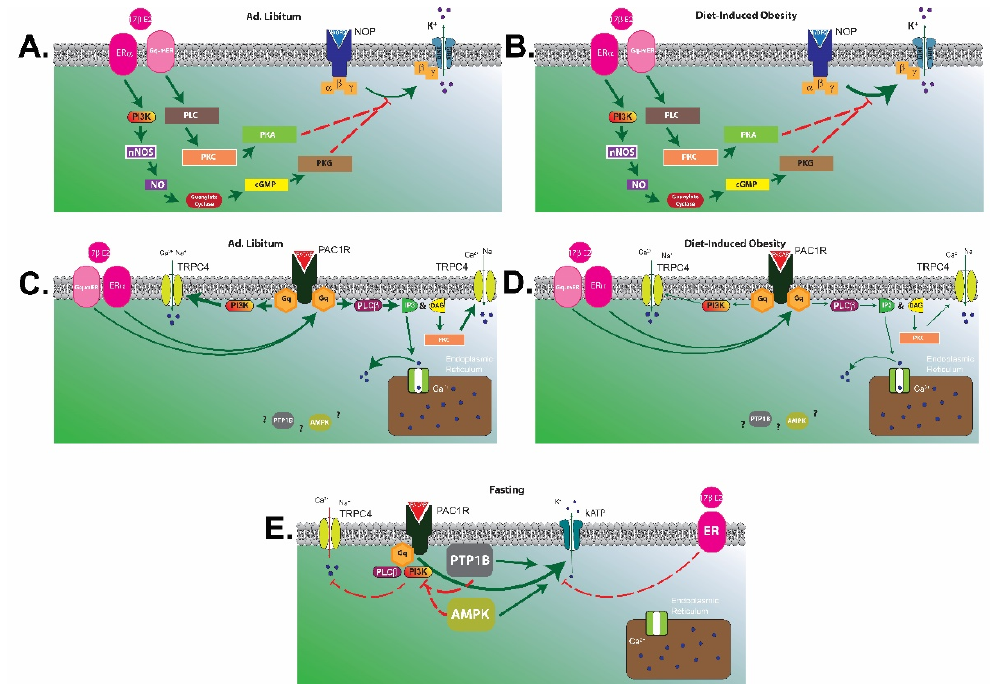
Figure 10. Schematic diagrams illustrating how PAC1 and NOP receptor signaling in POMC neurons is altered under various energy balance states. ( A ), In POMC neurons from ad libitum-fed animals, N/OFQ activates the NOP receptor that initiates G i/o -mediated signaling and subsequent activation of GIRK channels through positive allosteric modification by the βγ complex. This in turn promotes K + efflux and inhibition of POMC neurons, effects which are dampened by E 2 acting through ER α and G q -mER to stimulate PI3K and nNOS as well as PLC, PKC and PKA signaling pathways, respectively. ( B ), In POMC neurons from obese animals, NOP receptor/effector coupling is enhanced; leading to a greater inhibitory effect of N/OFQ on POMC neurons. This N/OFQ-induced inhibition of POMC neurons is once again abrogated by E 2 in POMC neurons from obese females. ( C ), Under ad libitum conditions, PACAP activates its cognate PAC1 receptor to elicit G q -mediated signaling; working through PI3K as well as PLC, IP3, DAG and PKC to promote Ca 2+ mobilization from intracellular stores and the coupling of PAC1 receptors to TRCP5 channels. This leads to cation flux through the channel pore that depolarizes and thereby excites POMC neurons. In females, E 2 can act via ER α and Gq-mER to potentiate PAC1 receptor/TRPC5 channel coupling and PACAP-induced excitation of POMC neurons. ( D ), Under conditions of diet-induced obesity, the PAC1 receptor-mediated activation of TRPC5 channels in male POMC neurons is attenuated. However, in obese females the PACAP-induced excitation of POMC neurons is maintained due to the potentiating effect of E 2 . ( E ), Under conditions of fasting, the expression and activity of AMPK and protein tyrosine phosphatases like PTP1B is elevated in POMC neurons. This triggers a switch in the coupling of PAC1 receptors, such that they now are no longer linked with TRPC5 channels and instead inhibit rather than excite POMC neurons via activation of K ATP channels. This inhibitory effect of PACAP in POMC neurons from fasted animals is diminished by E 2 in